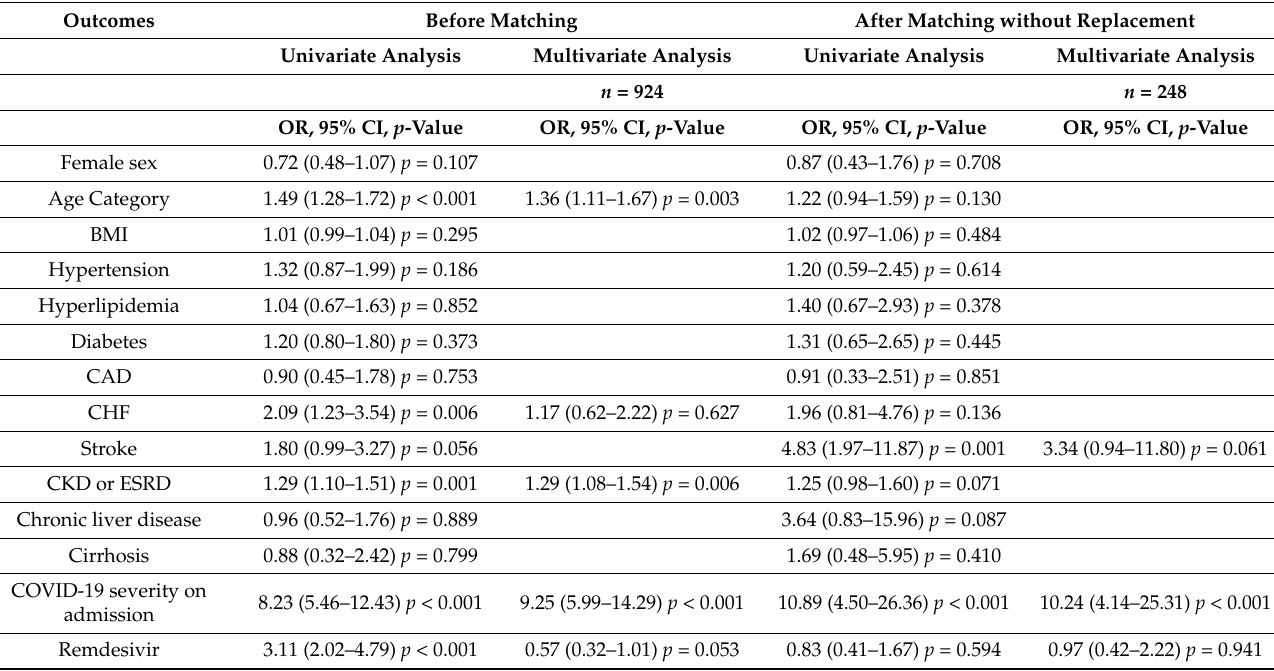
Table 7. Logistic Regression Analysis for In-hospital